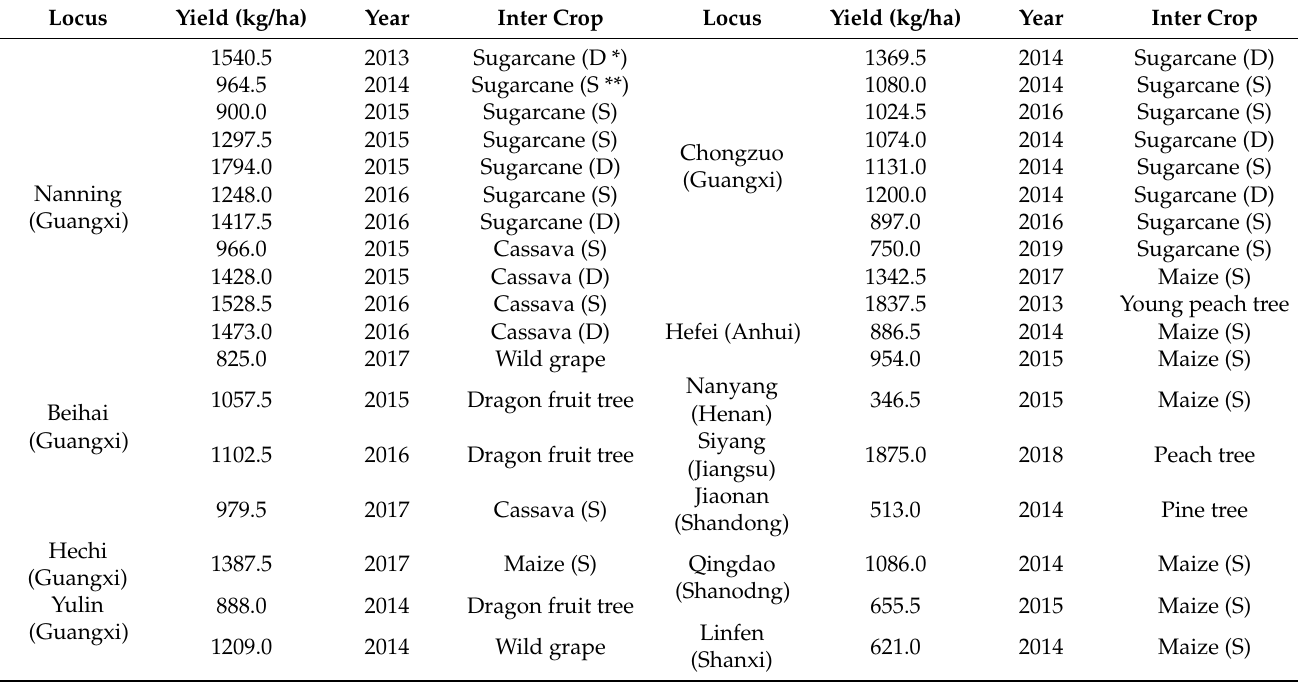
Table 2. Zhonglv 5 yields in intercropping systems from 2013 to 2019.